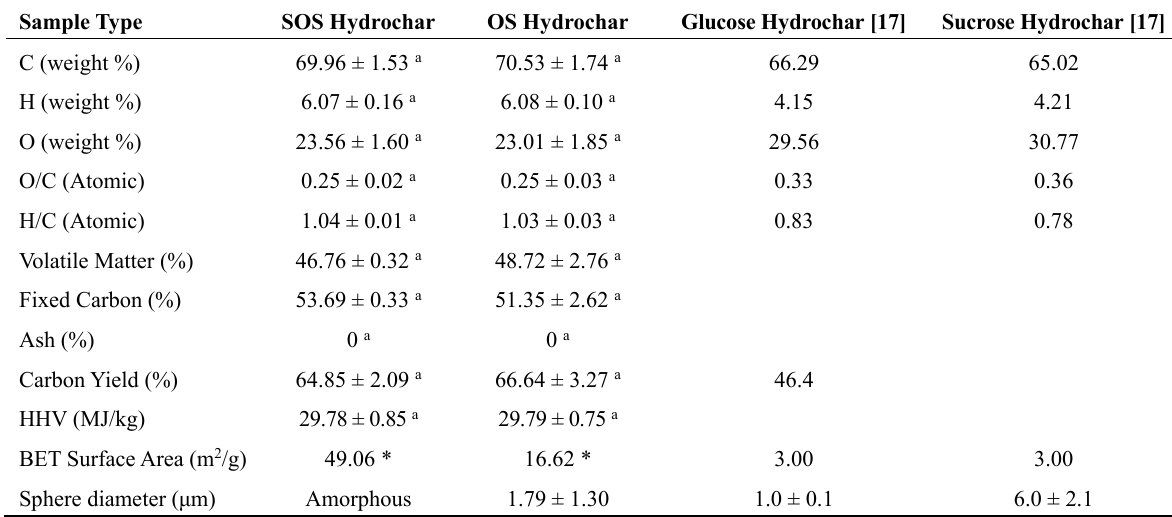
Table 6. Elemental and proximate analyses, higher heating values (HHV), and Brunauer-Emmett-Teller (BET) surface area of hydrochars made from SOS, OS, glucose and sucrose samples. The BET surface area was measure for devolatilized hydrochars only.